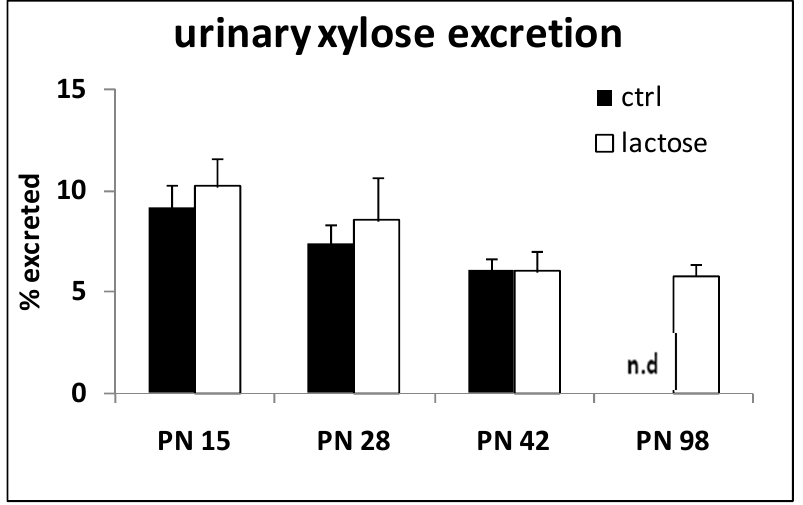
Figure 3. Urinary xylose output over 6 h expressed as a percentage of the amount orally instilled at t = 0, assessed at various time points postnatally (PN); ctrl ( n = 2), lactose ( n = 7–8) at each time point; n.d.: no data.